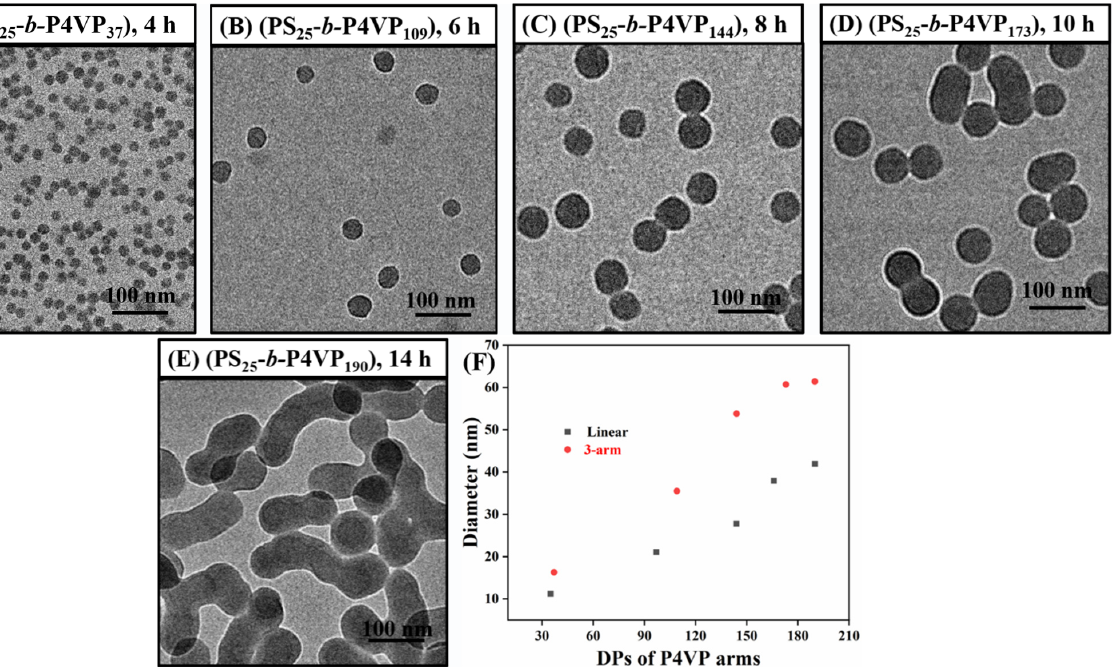
Figure 6. TEM images of 3-armed star (PS 25 - b -P4VP) 3 nanoparticles formed by RAFT dispersion polymerization at 4 ( A ), 6 ( B ), 8 ( C ), 10 ( D ),14 ( E ), and average diameter ( D ) of (PS 25 - b -P4VP) 3 and linear PS 24 - b -P4VP nanoparticles with the DP of P4VP arms increasing ( F